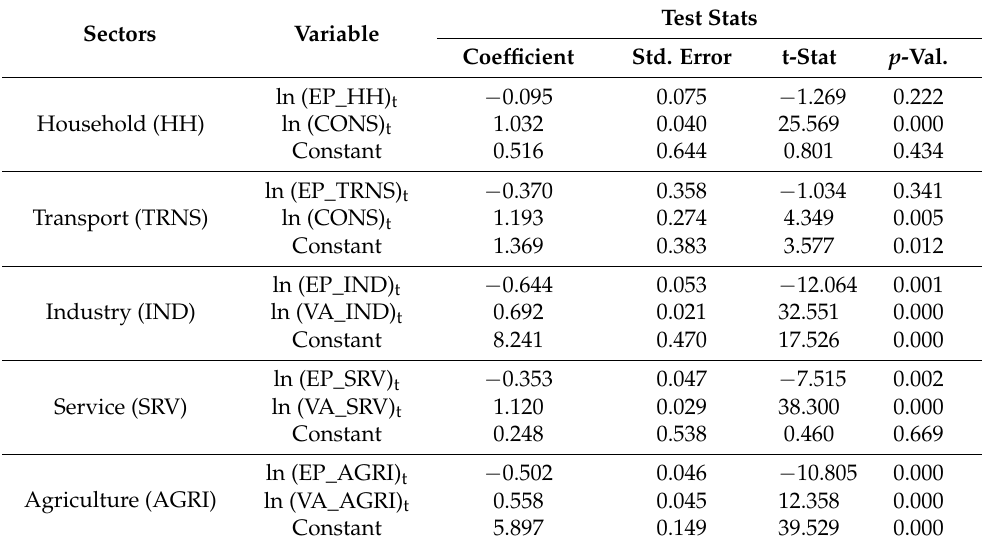
Table 17. Results for long-term